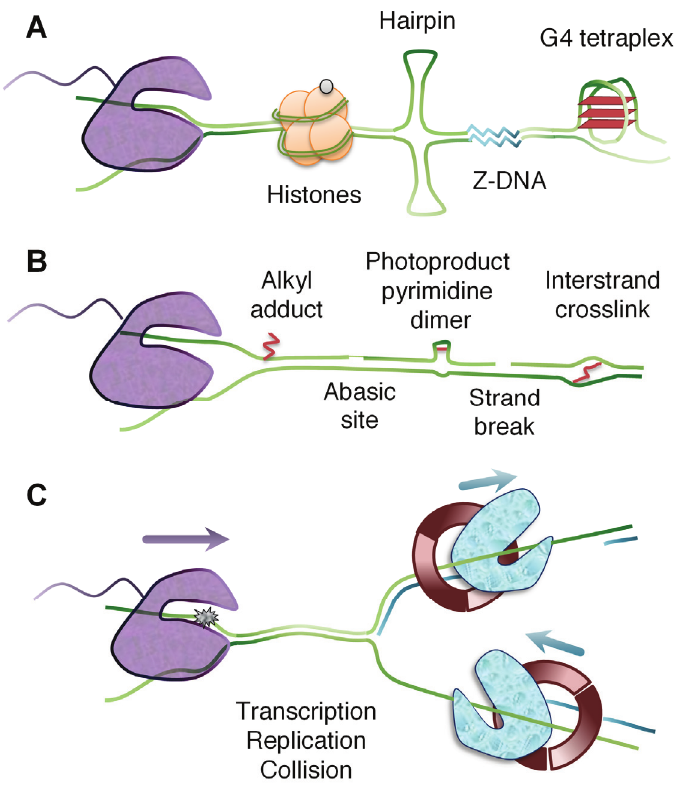
Figure 1. Blockage of transcription elongation. ( A ) DNA-binding proteins, such as histones, and non-B DNA structures, such as hairpins, Z-DNA, and G-quadruplexes. ( B ) DNA damage, including alkyl adducts induced by benzo[a]pyrene diol epoxide, N-nitroso; malondialdehyde or cyclopurines pyrimidine dimers induced by UV light; interstrand cross-links induced by platinum compounds (cisplatin, pyriplatin, phenanthriplatin); abasic sites and strand breaks induced as DNA repair intermediates. ( C ) Transcriptional arrest (abortion) due to convergent elongation of a replication